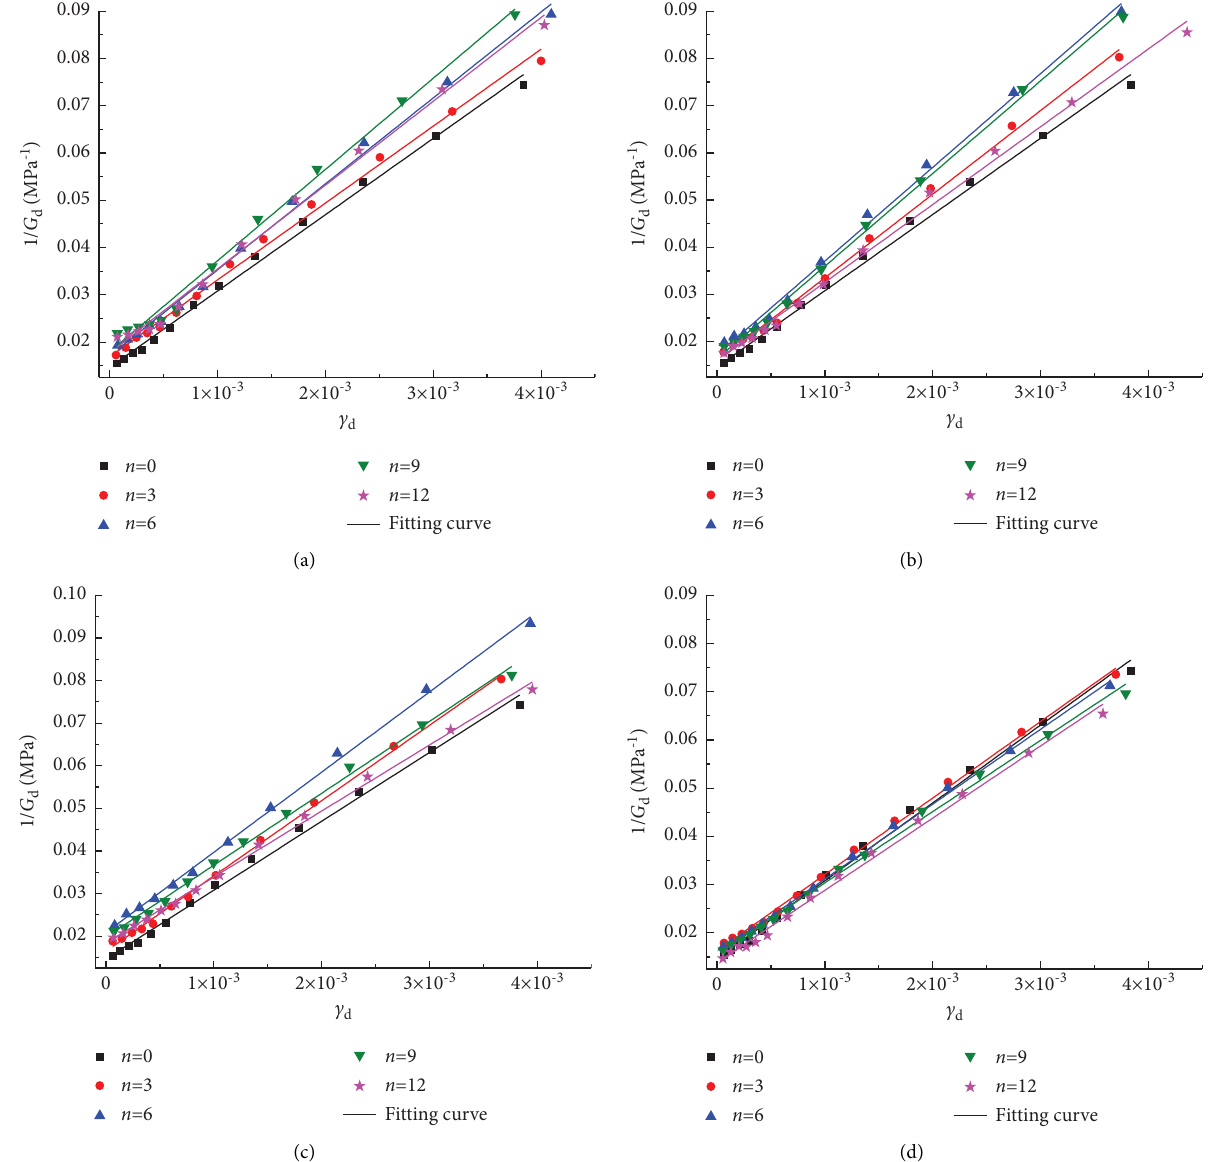
Figure 4: Te relationship between dynamic shear modulus G ( σ c � 200kPa, K � 1.5, f � 1 Hz, N � 5). (a) W - D cycle path a . (b) W - D cycle path b . (c) W - D cycle path c . (d) W - D cycle path d